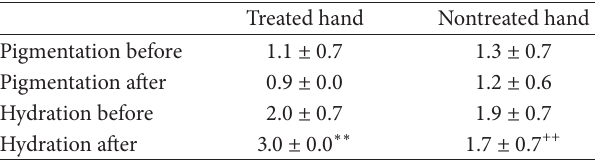
Table 1: Subjective evaluation of pigmentation and hydration before and after treatment. Pigmentation was more reduced on the treated hand than on theuntreated, without reaching statisticalsignificance. Hydration was significantly reduced in the treated hand after treatment compared to baseline ( ∗∗ 𝑝 ≤ 0.01 ) and compared to untreated hand after 3 months of moisturization with a standard cream ( ++ 𝑝 ≤ 0.01